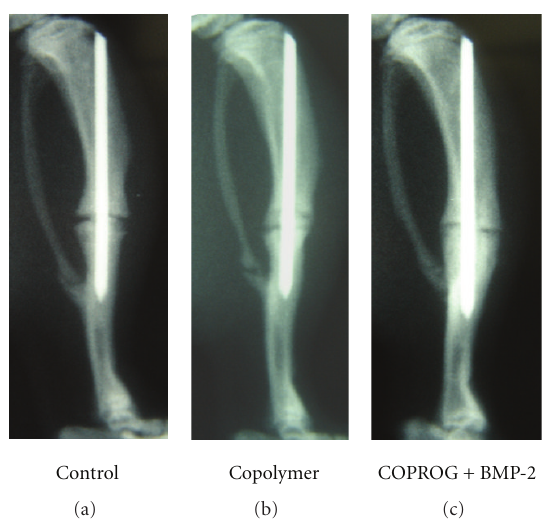
Figure 2: X-ray examination after 42 days (control, copolymer, and COPROG + BMP-2). The X-rays showed no di ff erence in terms of cortical